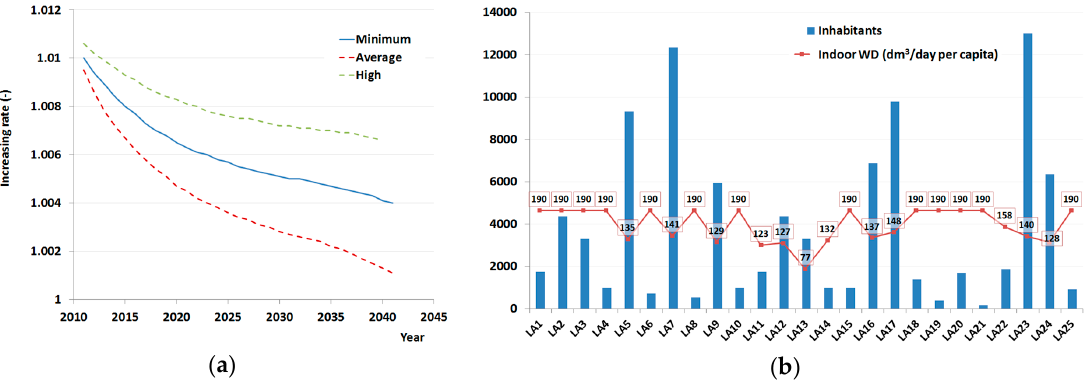
Figure 10. ( a ) Annual population-increase rate derived for the Emilia-Romagna Region [32]; ( b ) LAs served by the UWS, correspondent inhabitants and water demand based on indoor consumption. Table 6. Split coefficients between SCs and SRs, i.e., the served LAs directly linked.